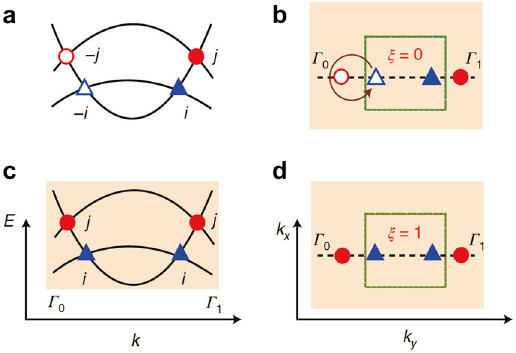
Figure 4: Schematic of a three-band system exhibiting the non-Abelian band nodes in two-dimensional momentum space. (a) Band structure with oppositely charges nodes. The blue triangles and red circles indicate the nodes whose charges are ± i and ± j , respectively. The open and filled symbols correspond to the plus and minus signs, respectively. (b) Braiding of the open triangle node around the open circle node. (c) and (d) Band structure with the nodes whose charges changed by a factor of − 1 after the tuning of (b). The patch Euler class is now 1. Reproduced with permission from Reference [124]. Copyright 2021, Nature Portfolio